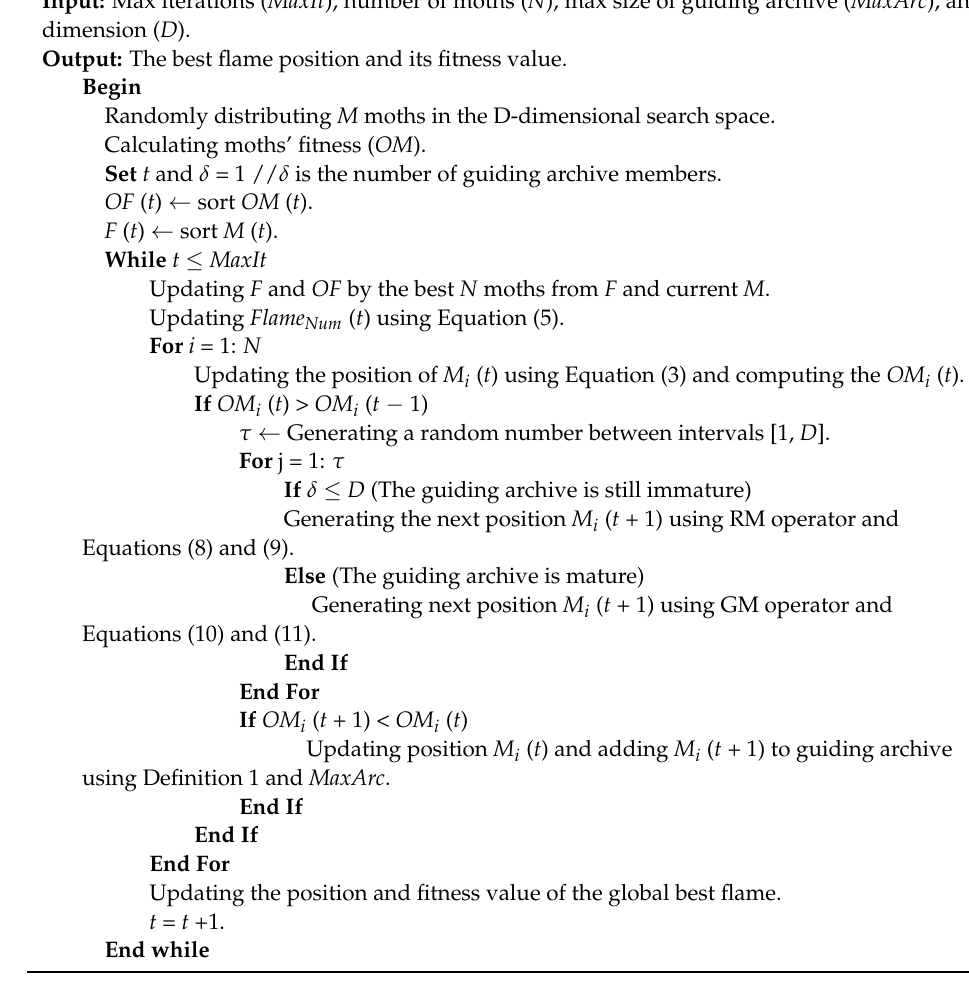
Algorithm 1. The pseudocode of proposed M-MFO